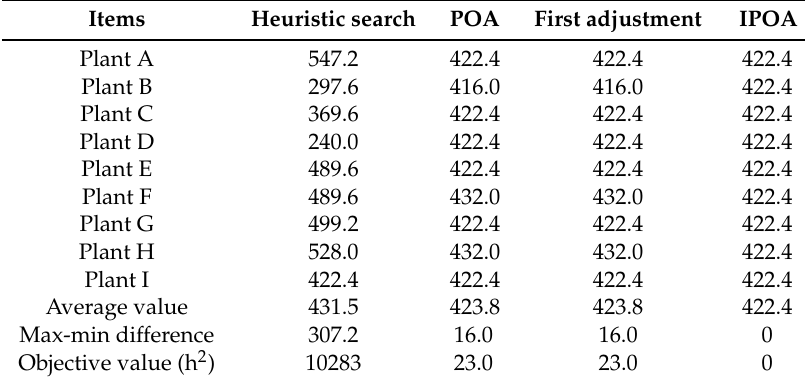
Table 2. Comparison of each power plant’s capacity utilization hours in October (h).